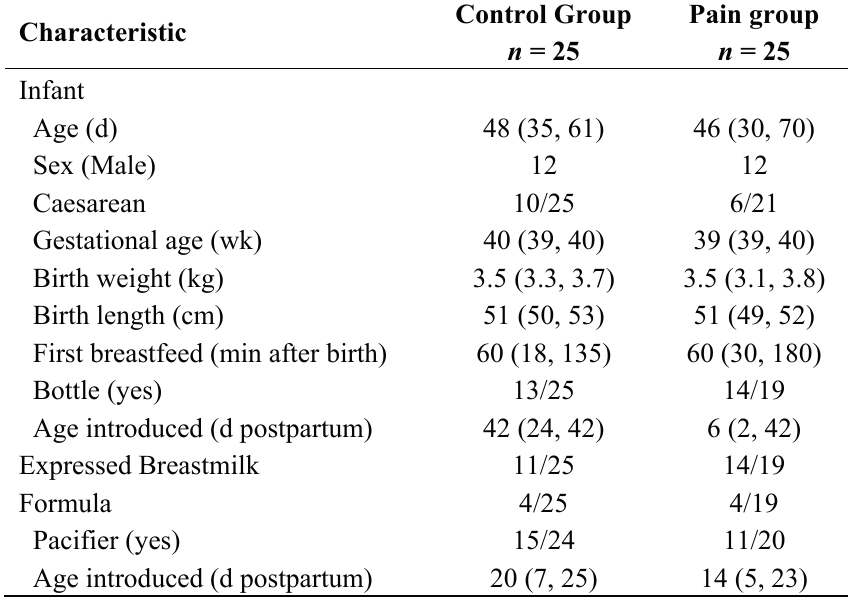
Table 1 . Characteristics of infants of Control group (mothers with no nipple pain) and Pain group (mothers experienced persistent nipple pain during